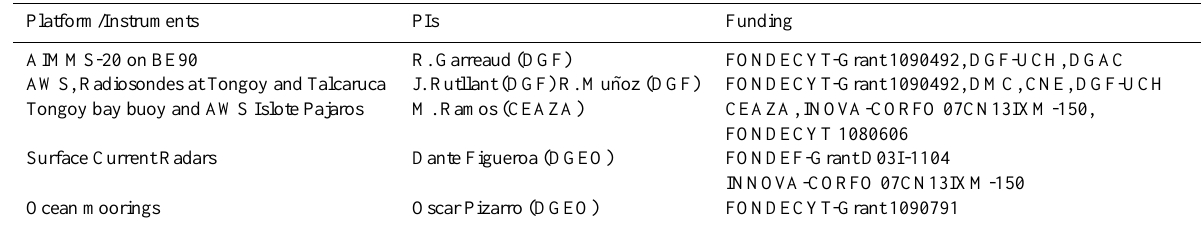
Fig. 3. (a) Spring-Summer (SONDJF) average of sea level pressure (contoured every 2hPa) and 10-m wind vectors (arrows) off the Chilean coast. Data source: NCEP-NCAR reanalysis. (b) Spring-Summer (SONDJF) average of surface wind speed derived from 4yr of QuikScat observations. Color scale at right in ms − 1 . Note the near coastal jets off points Choros (Cho), Lengua de Vaca (LdV) and Lavapie (Lav). Adapted from Garreaud and Mu˜noz (2005). (c) Spring (SON) climatology of low cloud frequency derived from visible GOES imagery (pink is > 80%; blue is less than 30%). Adapted from Gonzalez et al. (2007). Table 1. List of projects and institutions supporting